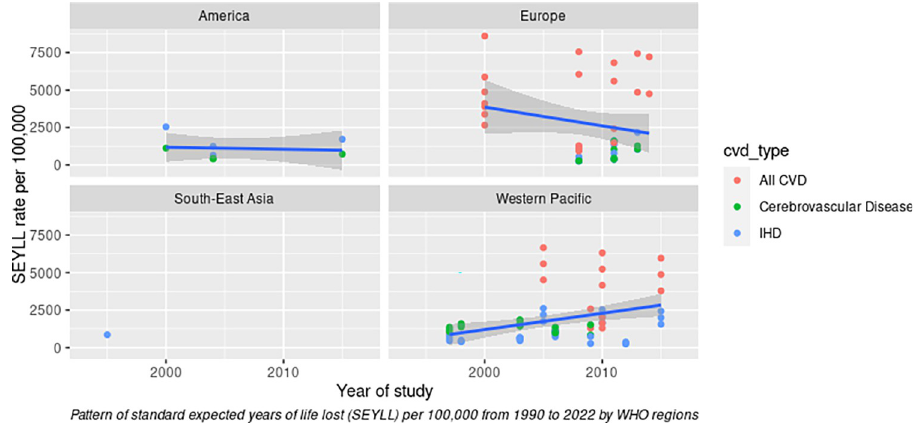
Fig 7. Patterns of SEYLL rate by WHO